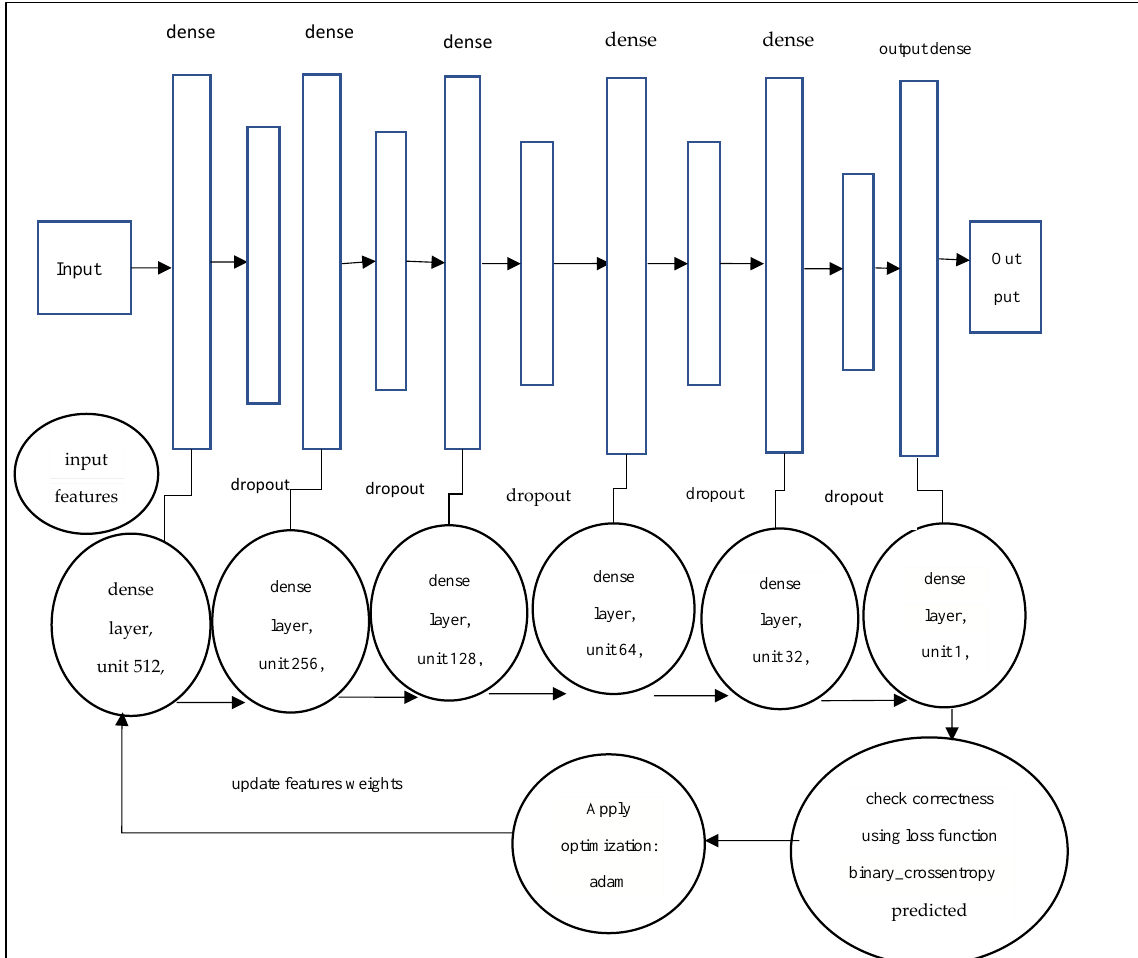
Figure 7. Layers architecture of the proposed model deep neural network.